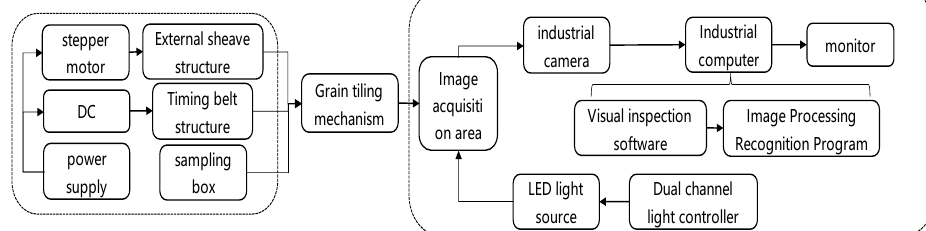
Figure 3. Workflow of the monitoring system.